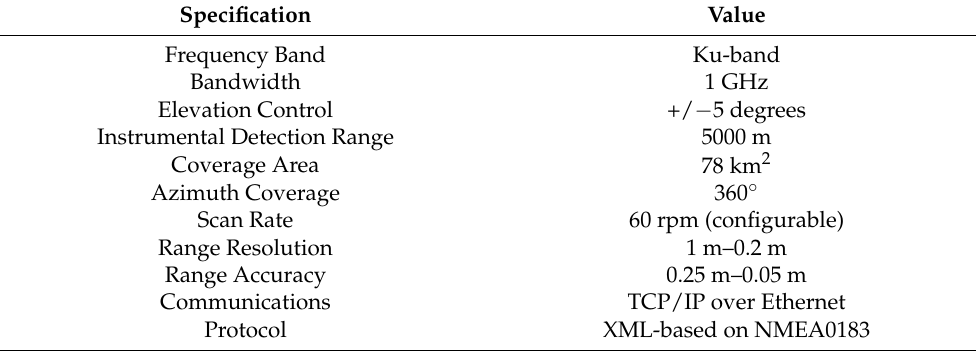
Table 1. ART Midrange 3D specifications.